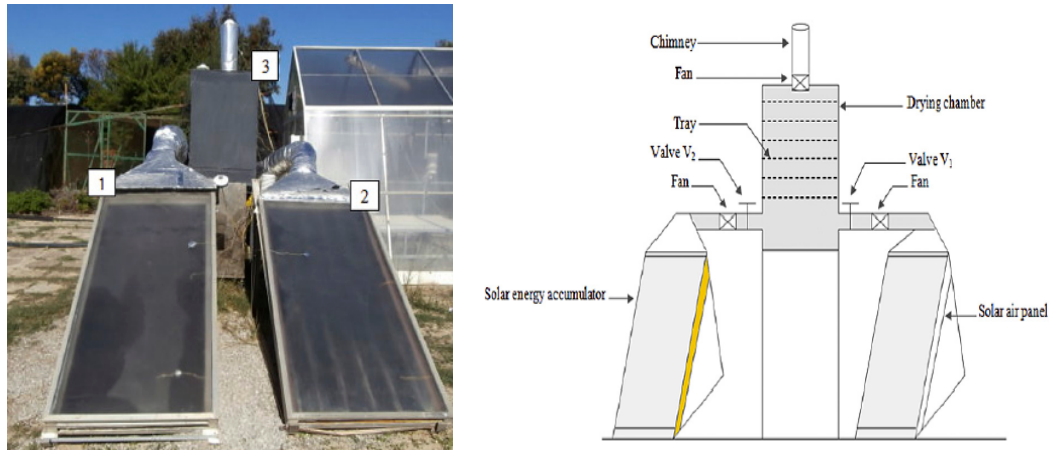
Figure 2. Indirect solar dryer (ISD) prototype, and schematic diagram of the ISD (figure taken from El Khadraoui et al. [26]).